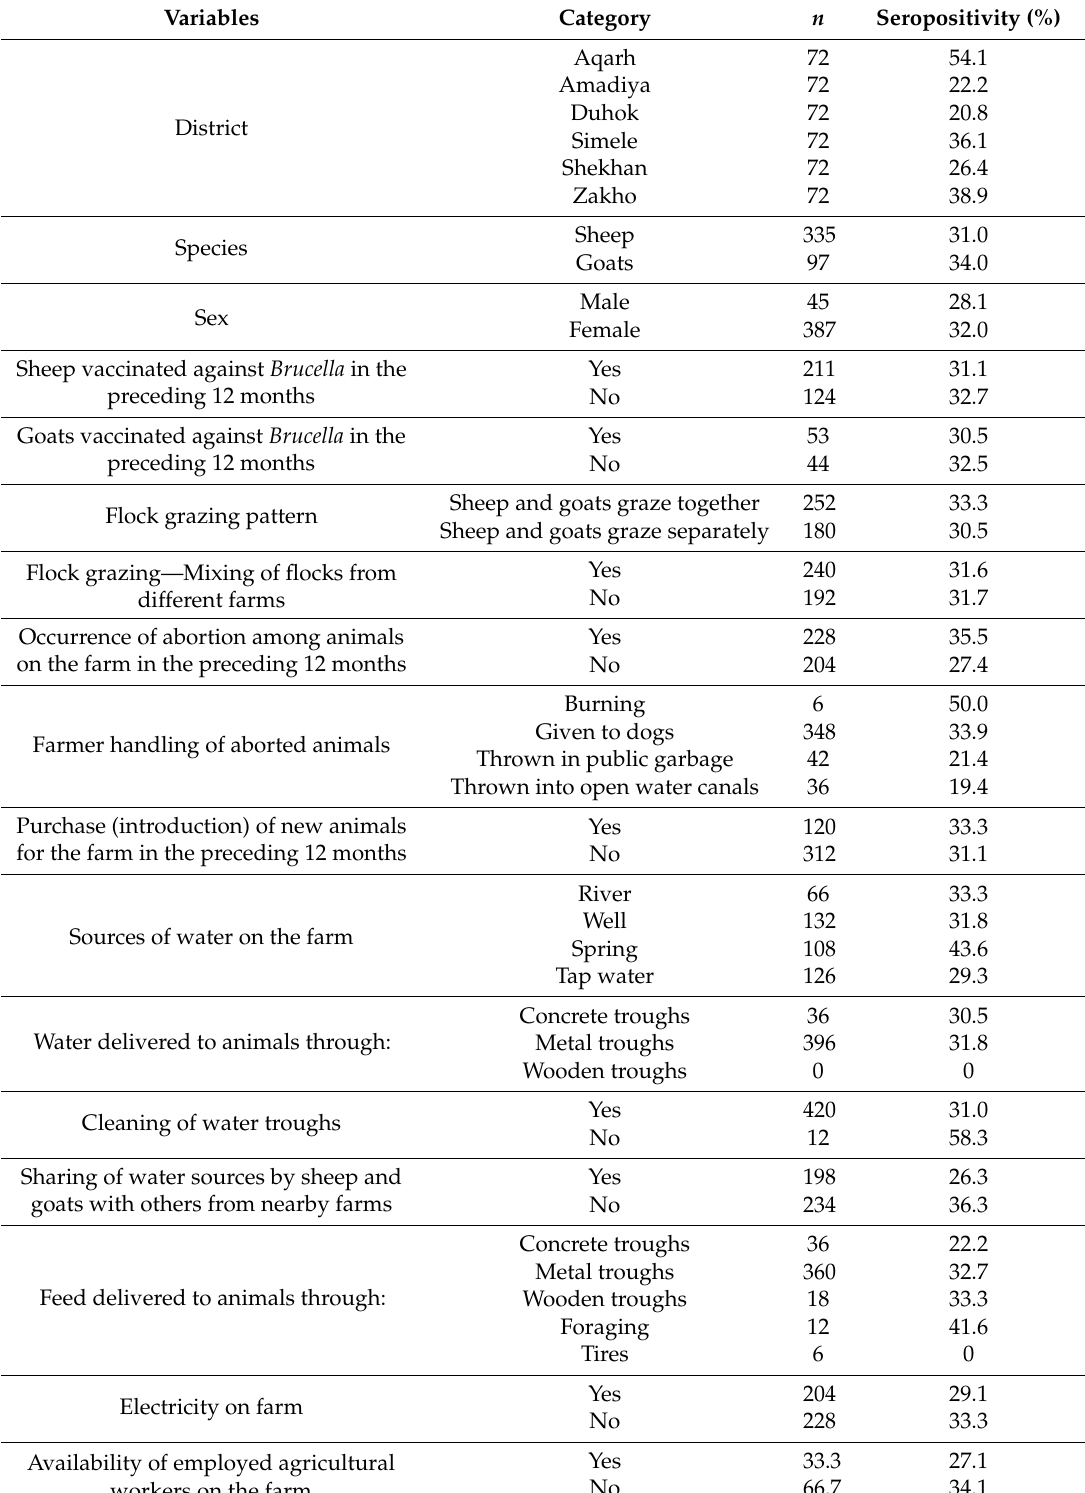
Table 2. Categorical risk factors associated with brucellosis seropositivity among small ruminants from Duhok Province (Iraq) using parallel interpretation of the Rose Bengal test (RBT) and indirect enzyme-linked immunosorbent assay